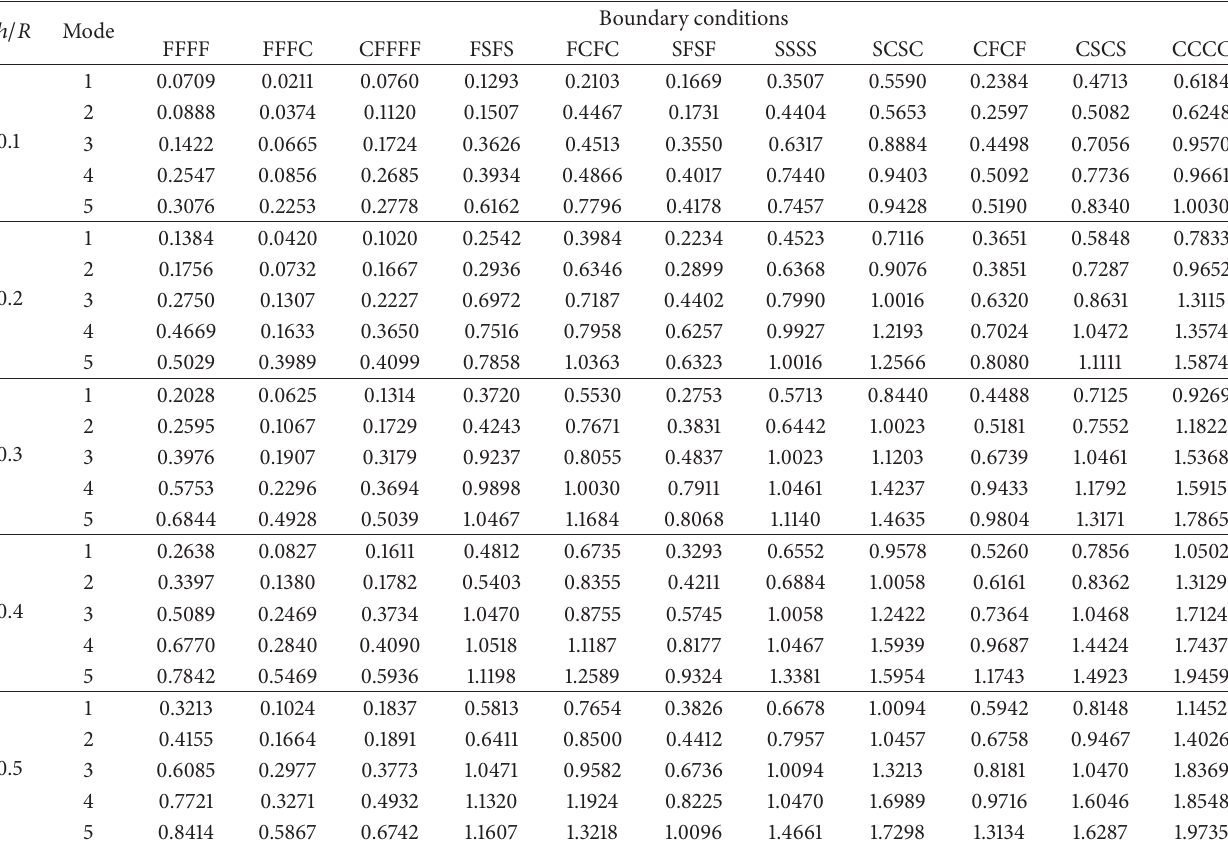
Table 5: The first five frequency parameters Ω = 𝜔𝑅√𝜌/𝐺 of an open isotropic cylindrical shell with various boundary conditions